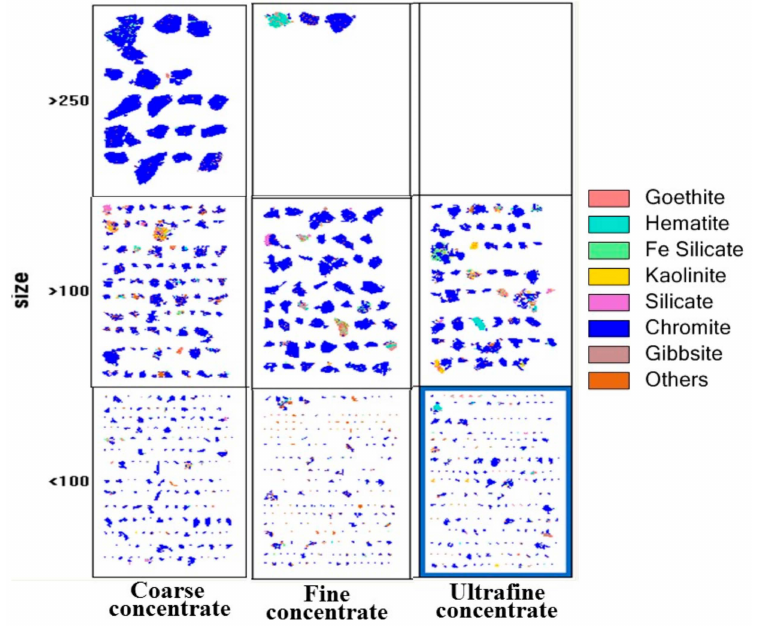
Figure 4. The QEMSCAN images of the samples in di ff erent size